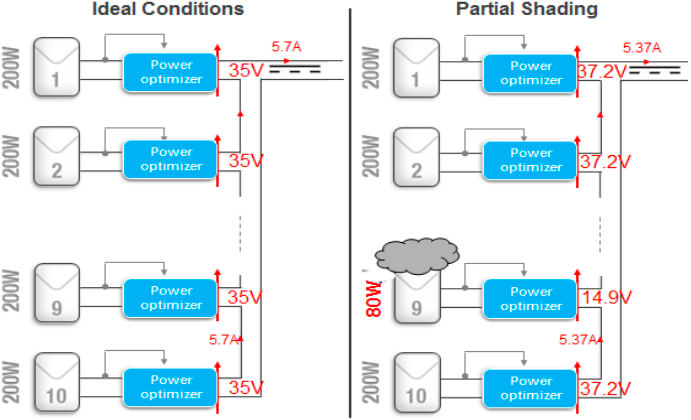
Figure 4. Operation principle of SolarEdge systems based on DC/DC power optimizers [33]. During the monitoring period, the fixed photovoltaic platform was south-oriented (0 ◦ azimuth angle) with a tilt angle θ = 43 ◦ (considering the horizontal plane as reference); this tilt angle is in the recommended range for our location’s latitude in order to capture a high portion of the available solar irradiance [34–37]. The position of the tracked photovoltaic platform was adjusted stepwise about the vertical axis to change its azimuthal angle ( ψ ) and about the horizontal axis to change its elevation angle ( α ). An example of the solar-tracking programme is presented in Figure 5 through the variation of the solar angles ( α and ψ ) and of the PV platform ( α n and ψ n ) during the summer solstice (21 June). The continuous variation of the solar elevation angle is followed by the PV platform in six steps starting at 6:32 in the morning until 17:44 in the afternoon; outside this period the PV platform is kept at an elevation angle of 10 ◦ . The azimuthal angle of the PV platform ( ψ n ) is changed twelve times between 4:08 in the morning and 21:08 in the evening. At 4:08, the azimuthal angle of the platform is changed from 0 ◦ (south direction) to 90 ◦ (east direction) and kept in this position until 7:53. Between 7:53 and 16:01 the azimuth angle of the platform is changed each hour. At 16:02 the azimuthal angle reaches the value of − 90 ◦ (west direction) and is maintained at this value until 20:58 when it is changed back to 0 ◦ (south